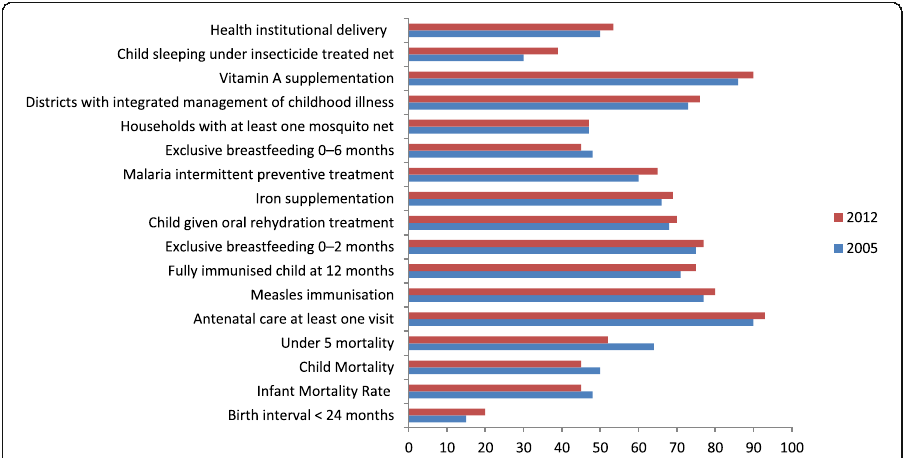
Fig. 1 Comparison of access to key child survival interventions between 2005 and 2012. Source: Computed by the authors. Data are from Demographic and Health Survey in Tanzania Demographic Health